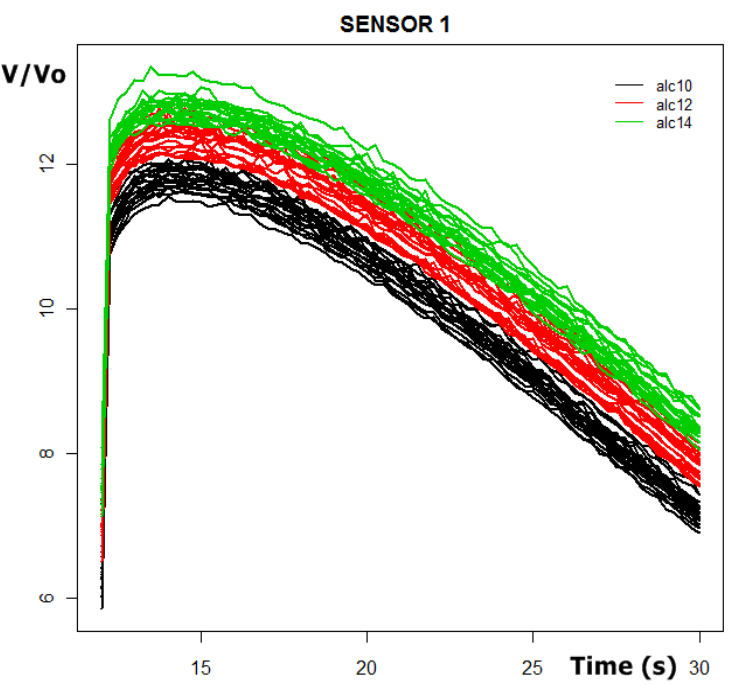
Figure 6. Sensor 1 response curves for the 60